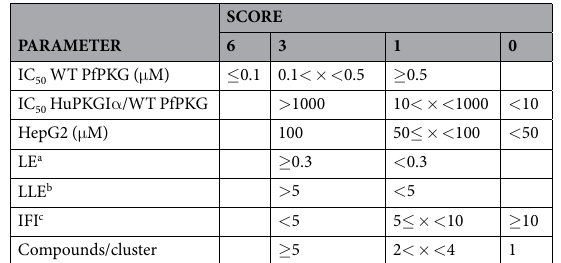
Table 1. Scoring system used to prioritize chemotypes. a Ligand efficiency b Lipophilic ligand efficiency c Inhibition Frequency